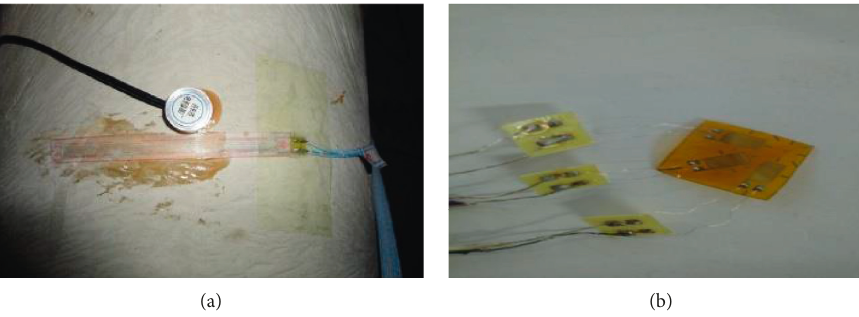
Figure 3: Test sensor. (a) Miniature pressure boxes. (b) Rectangular